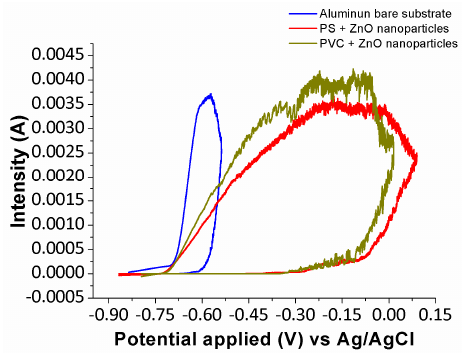
Figure 10. Pitting test plots for the Al bare substrate and the composite PVC–ZnO coating tested in 3.5 wt % NaCl aqueous solution.